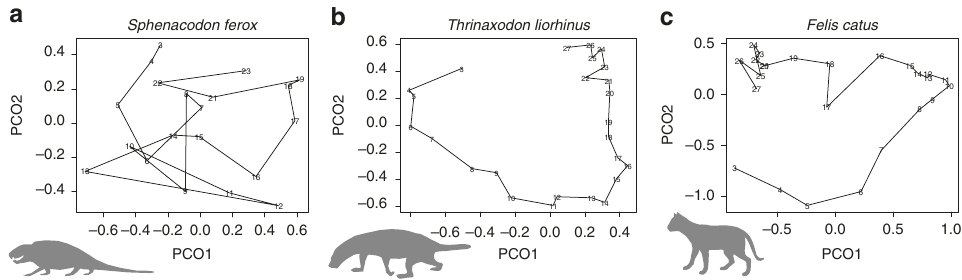
Fig. 6 Comparative morphology of vertebral columns. a A ‘ pelycosaur ’ , b a non-mammalian cynodont, and c a Boreoeutherian, illustrated using Principal Coordinates analysis. The vertebral columns of basal synapsids are relatively uniform (low range and polarization) but highly irregular. Through synapsid evolution, range and polarization increase, while columns become much smoother and more organized into